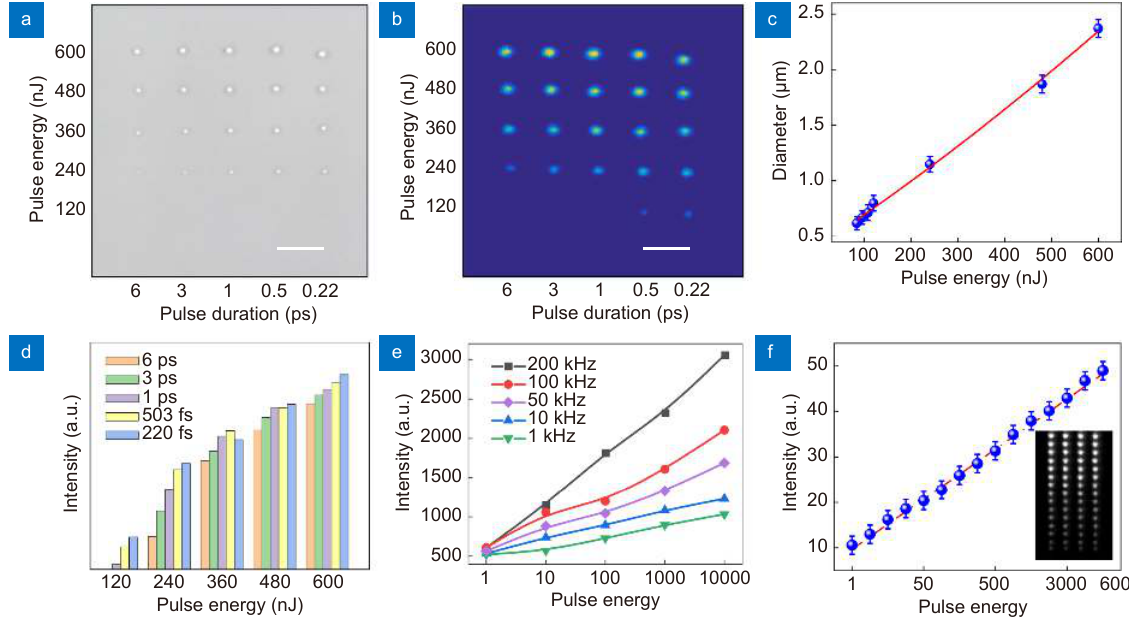
Fig. 2 | ( a ) Optical image of recorded information in the glass. ( b ) Reading out of information by PL mapping. Scale bar: 10 μm. ( c ) Relationship between emissive dot size and pulse energy. ( d ) PL intensity of dots written with diverse pulse durations and pulse energies. ( e ) PL intensity of dots written with various repetition rates and pulse numbers. ( f ) 16 levels of grayscale assignment based on the relation between PL intensity and pulse